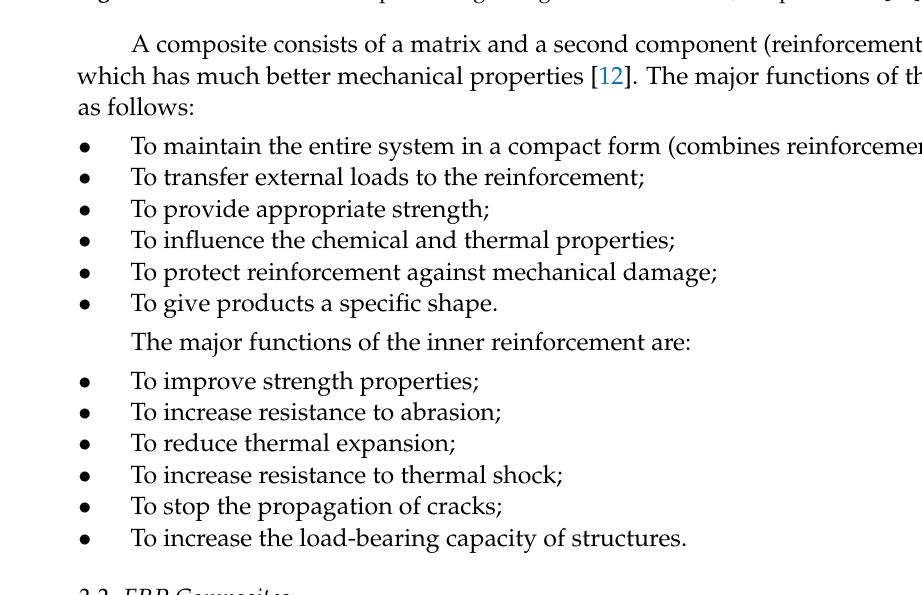
Figure 1. Classification of composites regarding their construction, adapted from [11].